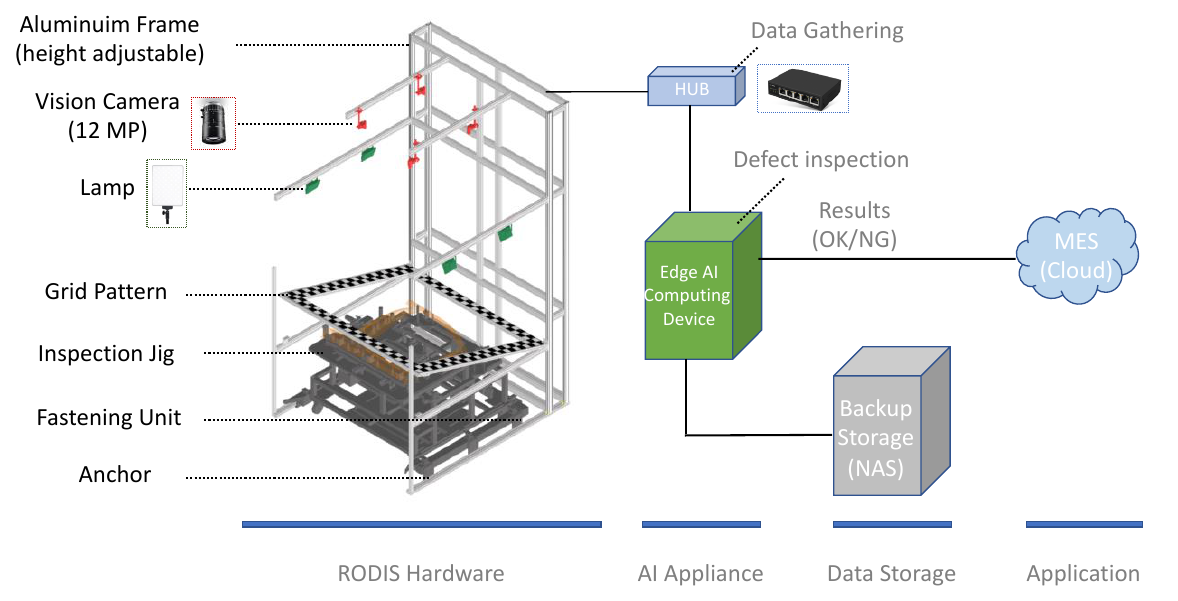
Figure 1. RODIS Framework.